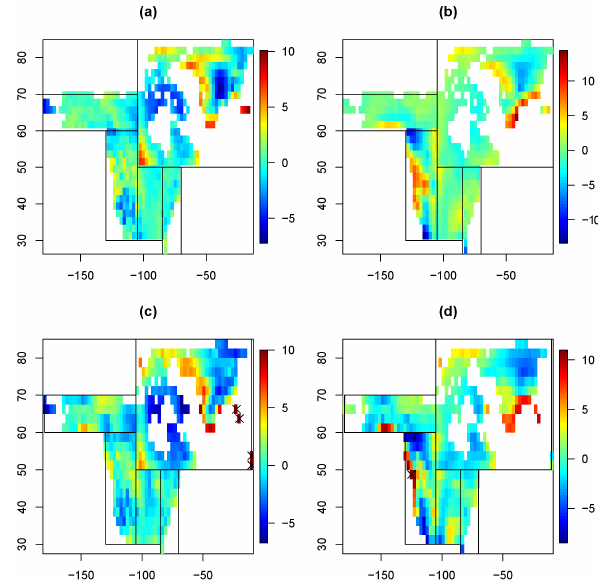
Figure 7. North America and Greenland DJF residuals: GFDL for (a) temperature and (b) 1000 (precipitation) 1 / 3 , and from NCEP/GPCP for (c) temperature and (d) 1000 (precipitation) 1 / 3 . In (c) and (d) there are a few pixels marked with an “X” with large residuals which have actual values beyond those